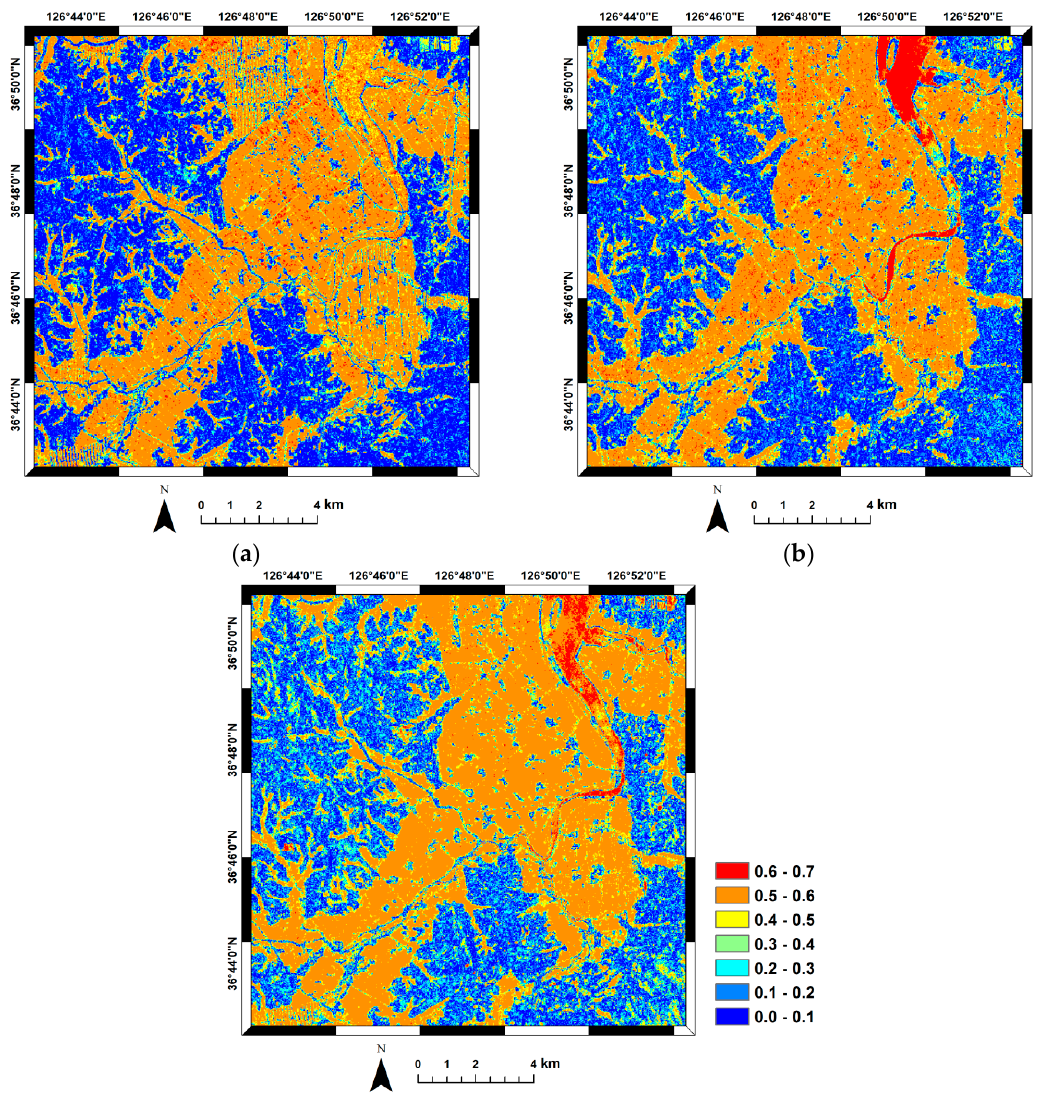
Figure 4. DCI maps: ( a ) Radarsat-1; ( b ) ENVISAT ASAR; and ( c ) fusion.